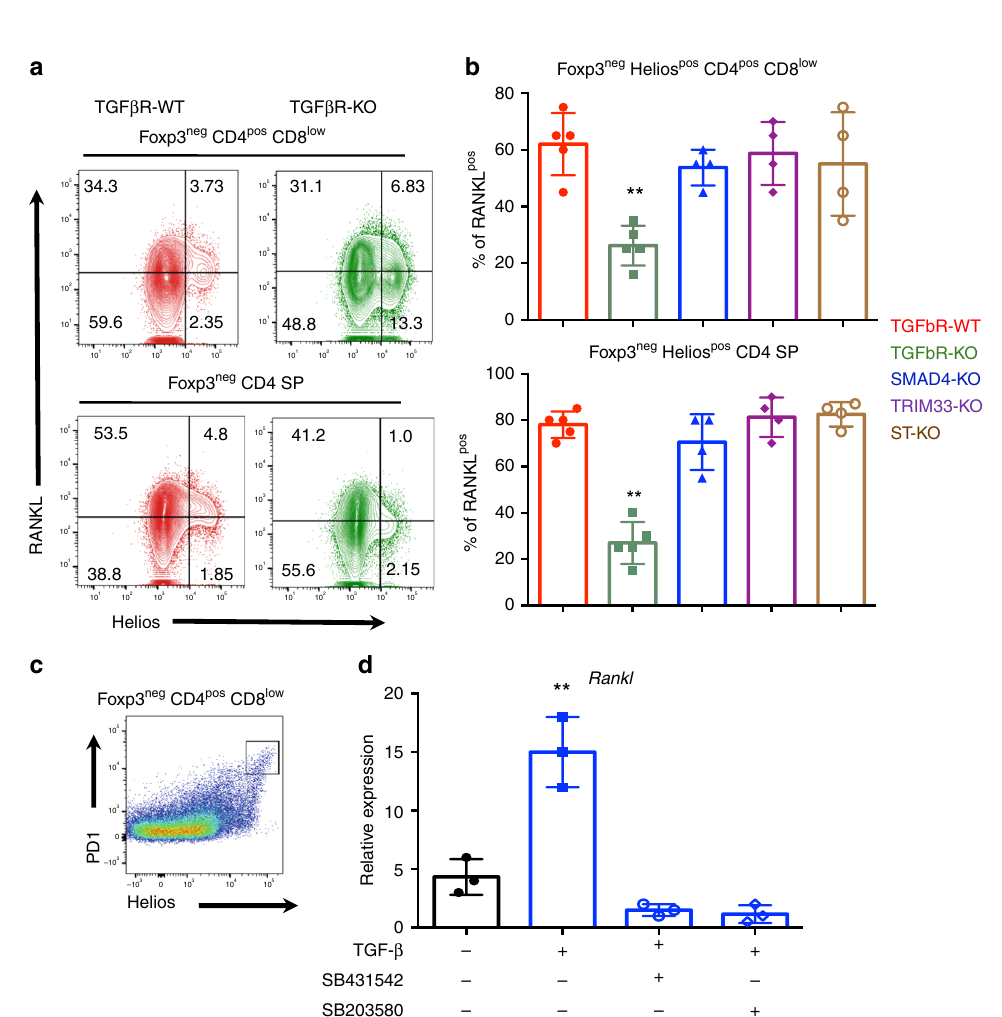
Fig. 4 TGF- β induces RANK-L expression in Helios pos thymocytes. a , b Flow cytometry analysis of RANK-L and Helios expression in Foxp3 neg CD4 pos CD8 low thymocytes and Foxp3 neg CD4 SP thymocytes based on gating strategy depicted in Fig. 1a. b Foxp3 neg CD4 pos CD8 low thymocytes and Foxp3 neg CD4 SP thymocytes from CD4-cre;smad4 fl / fl (SMAD4-KO) mice, CD4-cre;trim33 fl / fl (TRIM33-KO) mice, CD4-cre;smad4 fl / fl ; trim33 fl / fl (ST-KO) mice were analyzed by fl ow cytometry for RANKL expression. Histograms demonstrate the percentages of RANKLpos among the two populations. c FACS sort gating strategy. d FACS-sorted Foxp3 neg PD1 pos CD4 pos CD8 low thymocytes from TGF β R-WT mice were then cultured for 3 – 4 h with anti-CD3 antibodies to mimic TCR stimulation in the presence of TGF- β , TGF β -R inhibitor (SB431542) and p38 MAPK inhibitor (SB203580). Histograms illustrate the relative expression of rank-l measured by q-RT-PCR and normalized to gadph expression. All the experiments were conducted in 7 – 10-day-old animals. Data are representative of 2 – 3 experiments, with 3 – 5 mice per group. * P < 0.05, ** P < 0.01, *** P < 0.001 (two-tailed Student ’ s t test). Error bar, mean ± SEM. Source data are provided as a Source Data fi